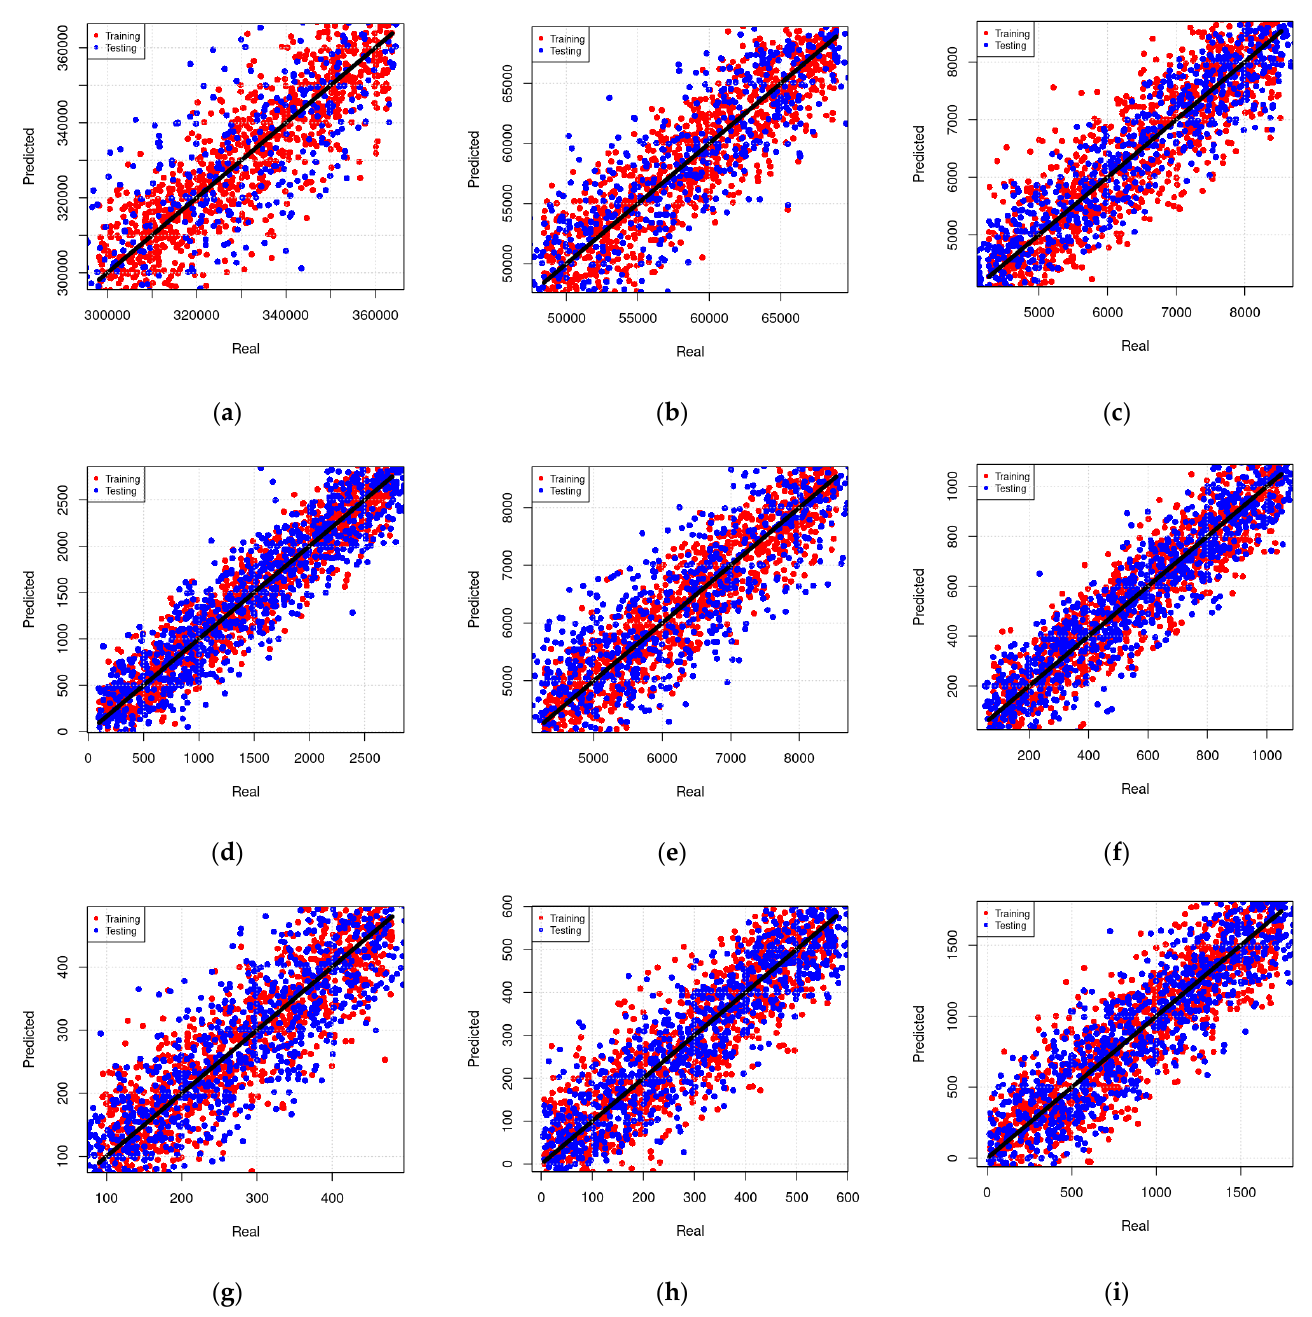
Figure 11. Assessment under training and testing phases. Real vs. predicted values for selected models are shown, ( a ) MLR model to predict the concentration of Si as a function of Cu, Zr con- centrations, ( b ) MLR model to predict the concentration of Cu as a function of AL, Fe, Zr, and Ba concentrations, ( c ) MLR model to predict the concentration of Ni as a function of all other microele- ments concentrations, ( d ) RF model to predict the concentration of Al as a function of Cu and Zr concentrations, ( e ) RF model to predict the concentration of Ti as a function of Ba, Cr, Cu, Y, and Mn concentrations, ( f ) RF model to predict the concentration of Fe as a function of all other micro- element concentrations, ( g ) MARS model to predict the concentration of Ni as a function of Cu, Zr, and Mn concentrations, ( h ) MARS model to predict the concentration of Mn as a function of Y, Ni, Fe, Si, and Ba concentrations, ( i ) MARS model to predict the concentration of Si as a function of all other microelement concentrations.